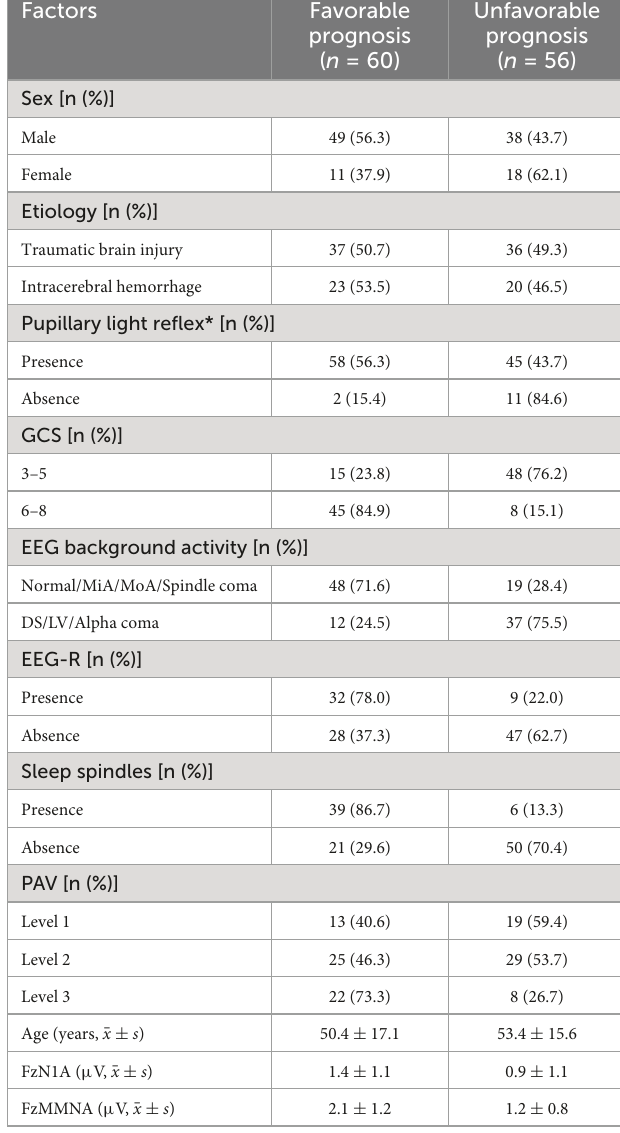
TABLE 1 Demographic and clinical characteristics of the patients in favorable and unfavorable prognosis groups.